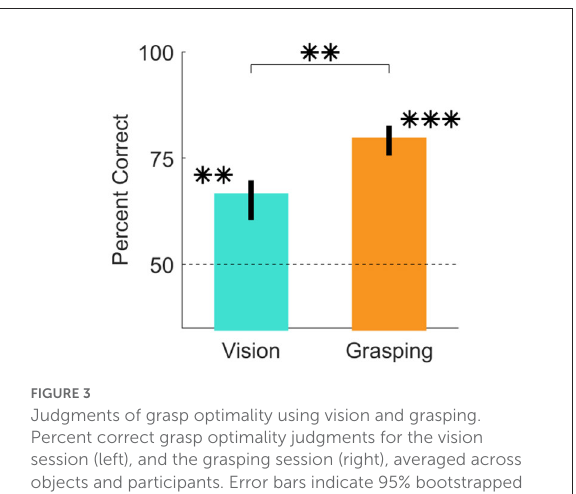
FIGURE3 Judgments of grasp optimality using vision and grasping. Percent correct grasp optimality judgments for the vision session (left), and the grasping session (right), averaged across objects and participants. Error bars indicate 95% bootstrapped confidence intervals of the mean. Chance performance is 50% correct (dotted line). ** p < 0.01; *** p <